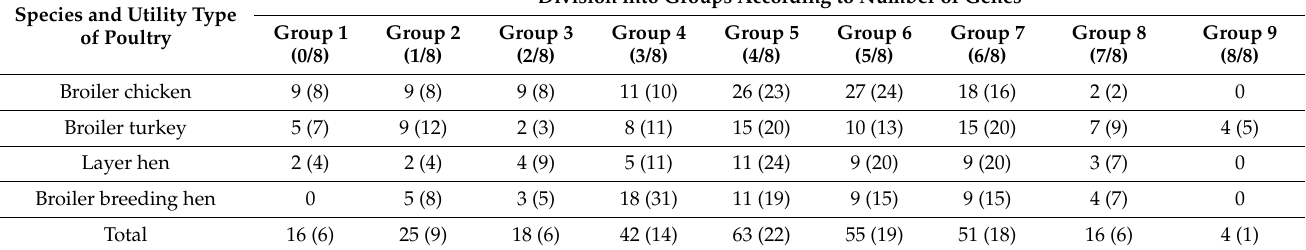
Table 5. Distribution of numbers of virulence genes in E. coli isolates obtained from each species and utility type of poultry.